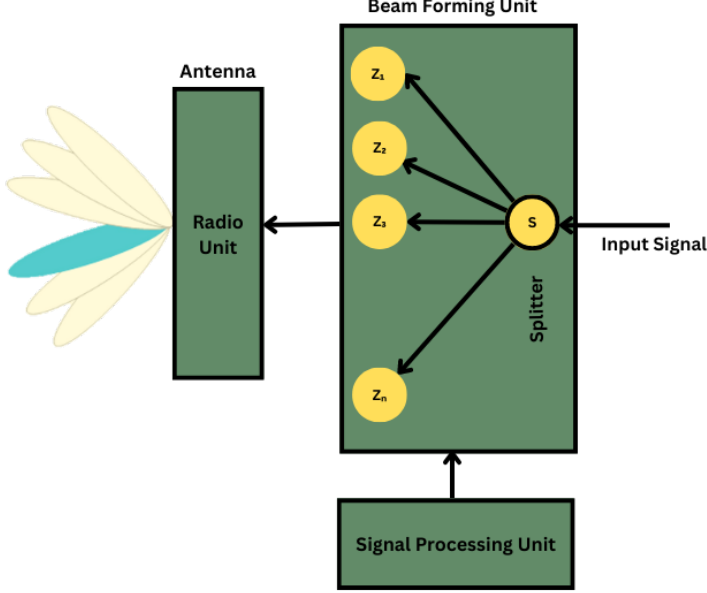
Figure 1. Transmitter antenna of the proposed MIMO system.